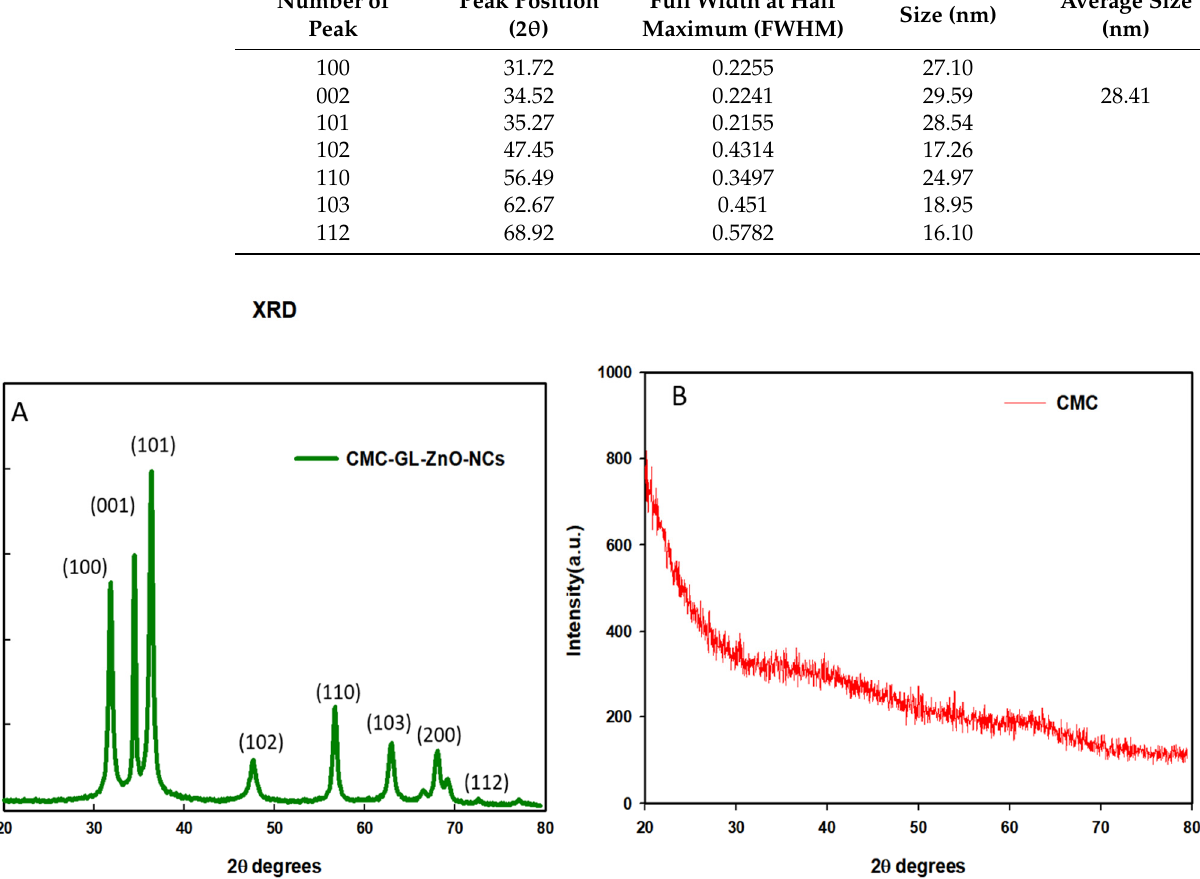
Figure 4. XRD patterns of the GL–CMC–ZnO NCs ( A ) and the polymer CMC ( B ).